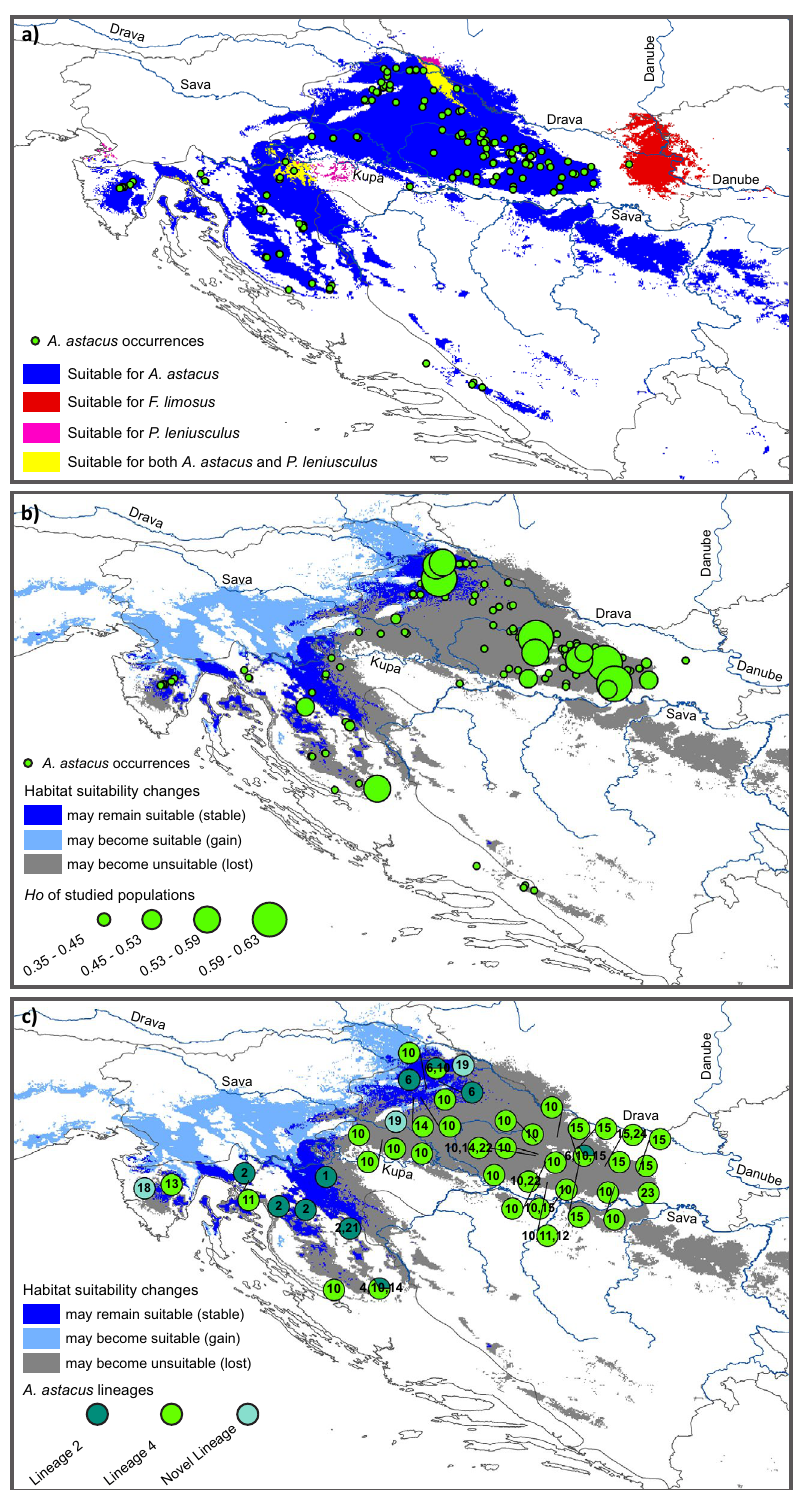
Figure 4. Potential overlap between suitable habitats for Astacus astacus and the two NICS. ( a ) Potential overlap between suitable habitats for Astacus astacus and the two NICS, Pacifastacus leniusculus and Faxonius limosus shown under current conditions . Projected changes between current and future habitat suitability for A. astacus under RCP 8.5 scenario in 2070 in relation to ( b ) observed heterozygosity ( H o ) and ( c ) COI haplotypes depicted by numbers and coloured according to mitochondrial lineages (both corresponding to Fig. 1). Known species occurrences are also shown in ( a,b ). Maps were produced in ArcGIS 10.3 program package by authors of this